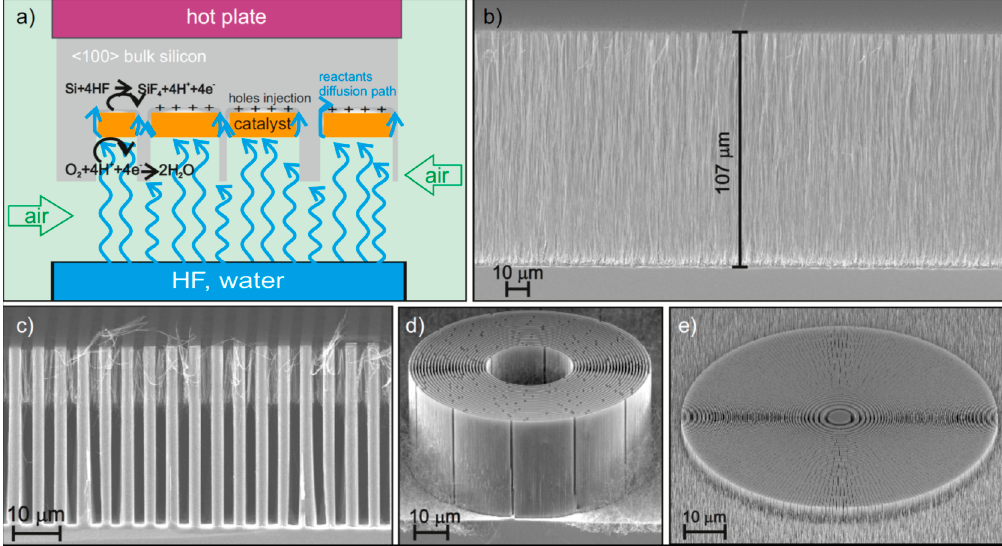
Figure 10. ( a ) Schematic of MacEtch in gas phase. SEM in cross section of structures by gas phase MacEtch at 55 °C, HF was evaporated from a water diluted HF solution and the oxidant is supplied by air: ( b ) Si nanowires; ( c ) linear grating with pitch of 4.8 µm; ( d ) circular grating with pitch 1 µm; ( e ) zone plate with outmost pitch of 200 nm. The figure was adapted with permission from L. Romano, 2020.